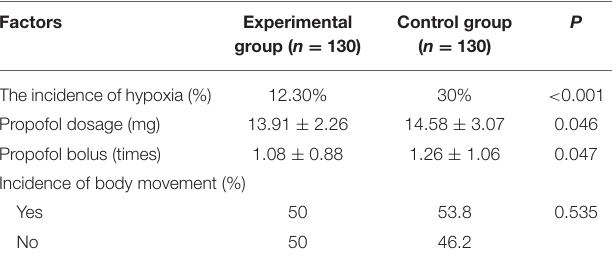
TABLE 2 | Perioperative